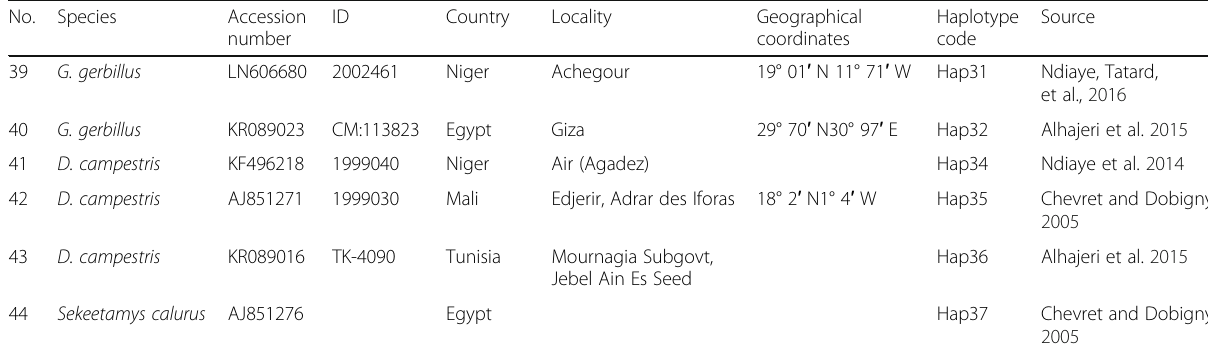
Table 1 List of specimens with their GenBank accession numbers of the sequences of cyt b (italicized numbers refer to original sequences in this study), geographic origin, haplotype code, and literature source (Continued) No.